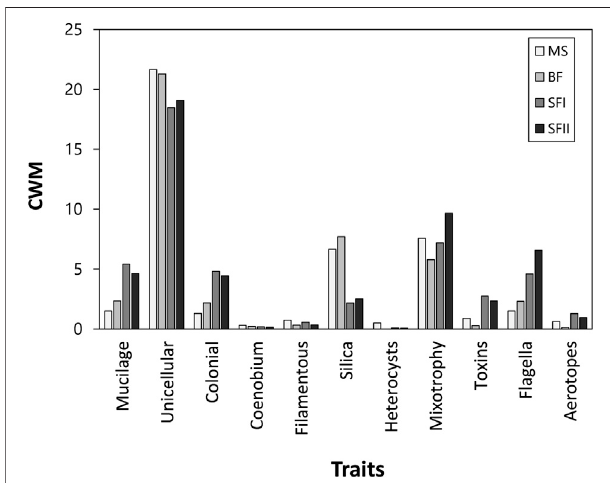
FIGURE 8 | Relationship between phytoplankton taxonomic and functional diversity index sampled from 2013 to 2018 in the three Small Hydroelectric Power Plant (SHP) reservoirs: Monte Serrat (MS; n = 24), Bonfante (BF; n = 24) and Santa Fé (SF I and II; n = 24). (A) Species richnessversusfunctionalrichnessand (B) ShannonIndexversusTotalCWM.